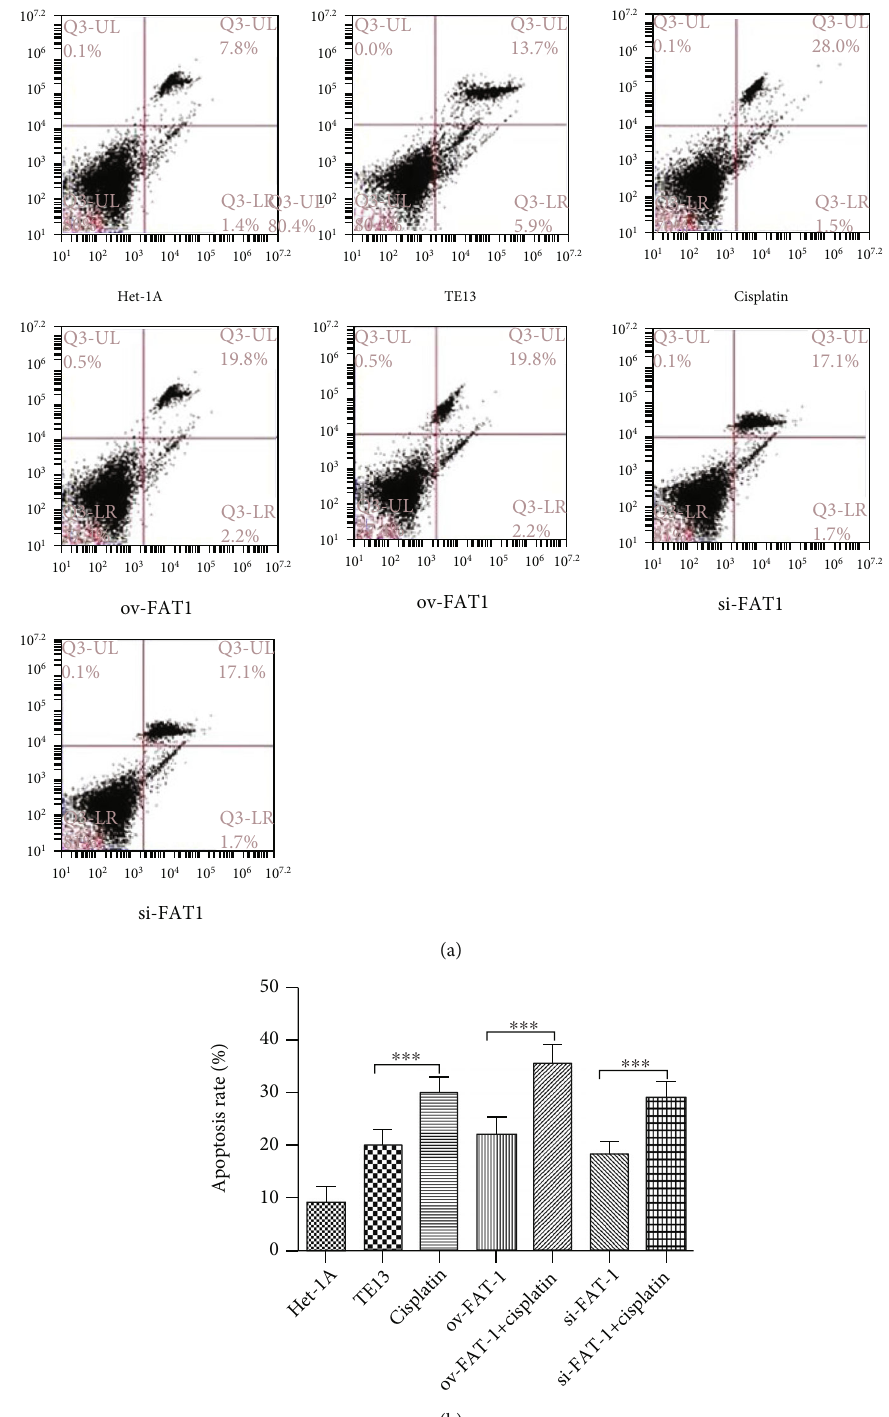
Figure 3: FAT1 promotes the apoptosis of human esophageal cancer cell lines. Human esophageal cancer cell lines het-1A and TE13 were cultured strictly. (a) FCM analysis for cell cycle and apoptosis was done 72 hours posttransfection, using the Annexin V-FITC/7-AAD Kit for apoptosis analysis. (b) Apoptosis rate of